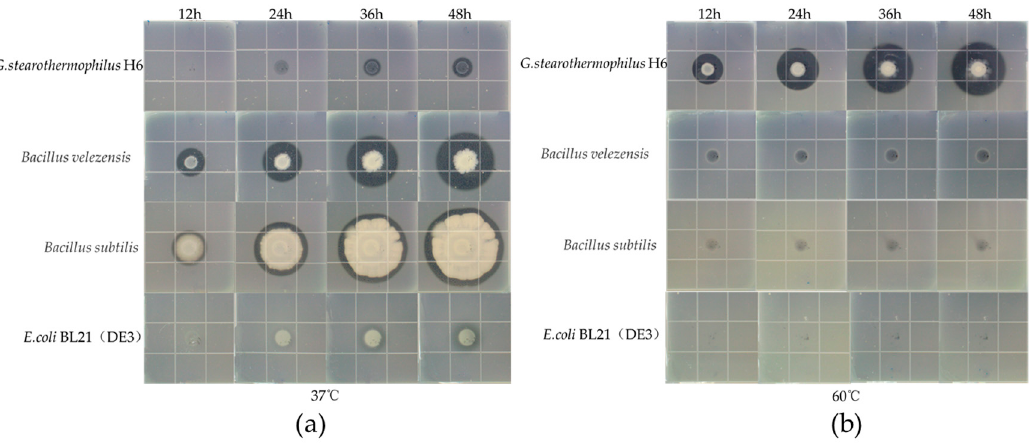
Figure 3. The experimental strains of bacteria were cultured on skimmed milk plates at 37 °C and 60 °C for 12 h, 24 h, 36 h and 48 h: ( a ) cultured at 37 °C; ( b ) cultured at 60 °C.